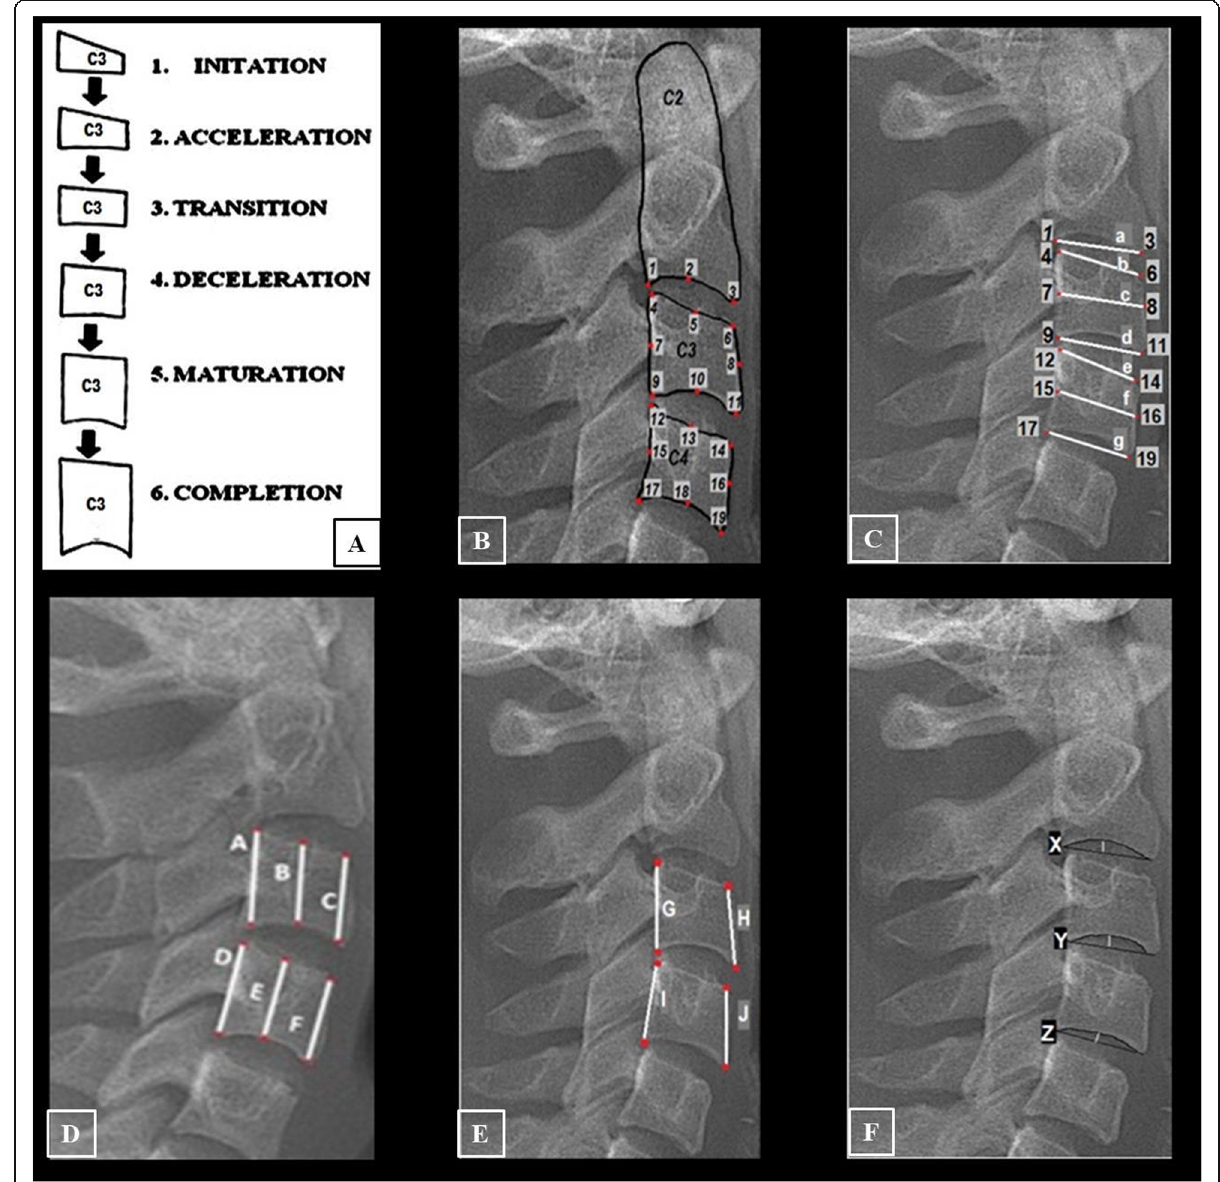
Fig. 1 The cervical vertebral references and measurements. a The observed alteration of C3. 18 . b The cervical vertebral reference points. c The horizontal linear measurements. d The vertical linear measurements. e The anterior and posterior vertebral slope measurements. f The vertebral depth